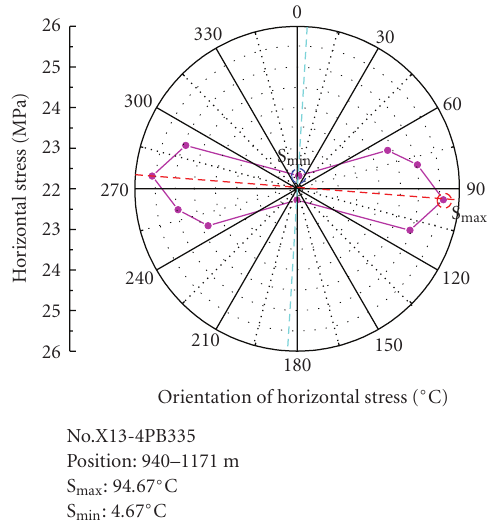
Figure 15: The orientation of the maximum horizontal stress by XMAC.